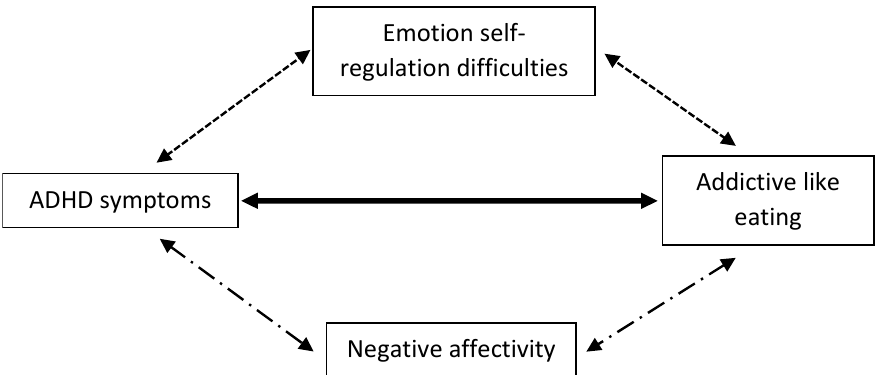
Figure 3. Model illustrating association between ADHD symptoms and disordered eating mediated by emotion self-regulation difficulties and negative affectivity.